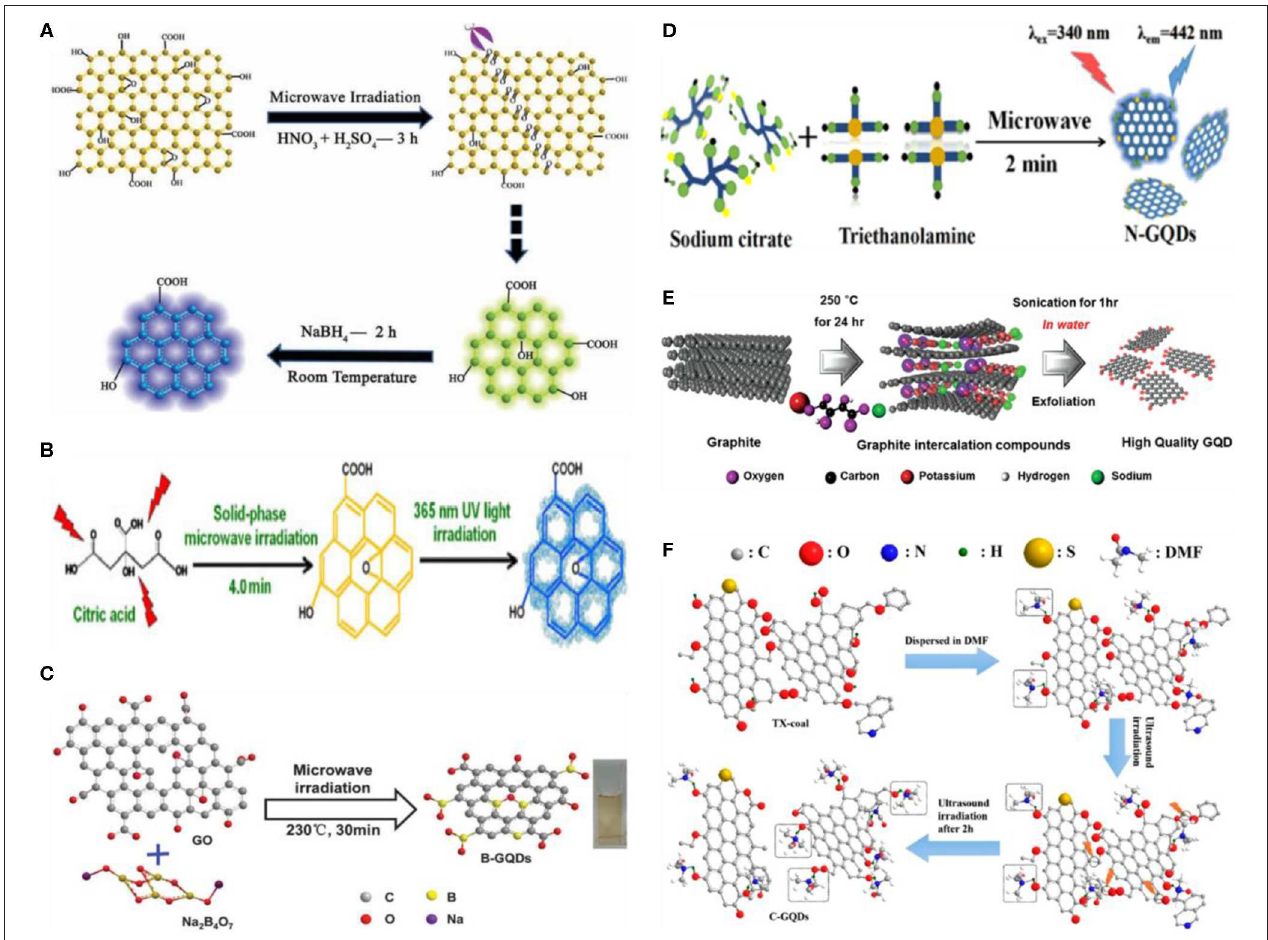
FIGURE 5 | (A) Illustration of the preparation of GQDs by microwave-assisted chemical cleavage of GO sheets; reproduced from Li et al. (2012a) with permission from Wiley. (B) Microwave exfoliation of citric acid to fabricate GQDs; reproduced from Zhuang et al. (2016) with permission from Wiley. (C) Preparation of boron-doped GQDs (B-GQDs); reproduced from Hai et al. (2015) with permission from the Royal Society of Chemistry. (D) Preparation of nitrogen-doped GQDs (N-GQDs); reproduced from Ren et al. (2019) with permission from the American Chemical Society. (E) Ultrasonic preparation of GQDs using graphite; reproduced from Song et al. (2014) with permission from Wiley, and (F) coal as a precursor; reproduced from Zhang et al. (2019b) with permission from the American Chemical